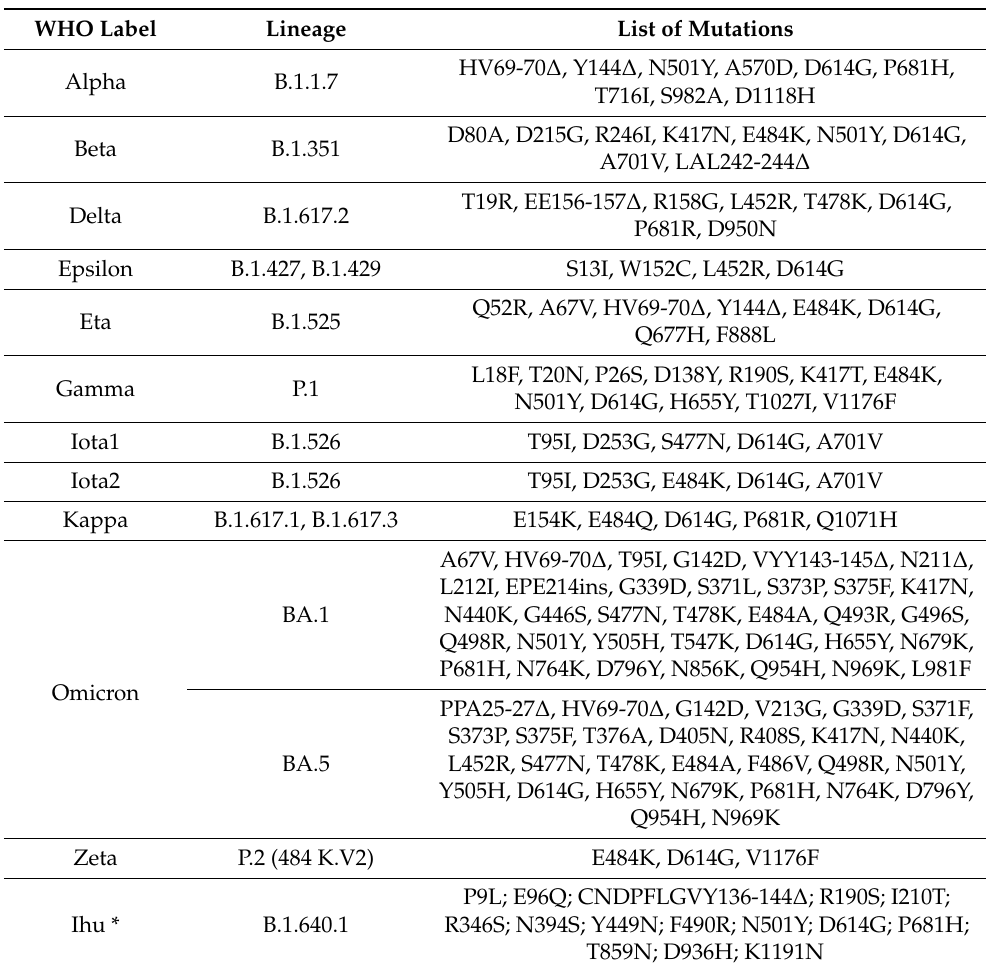
Table 1. SARS-CoV-2 spike variants whose 3D models and MD trajectories are distributed through the web